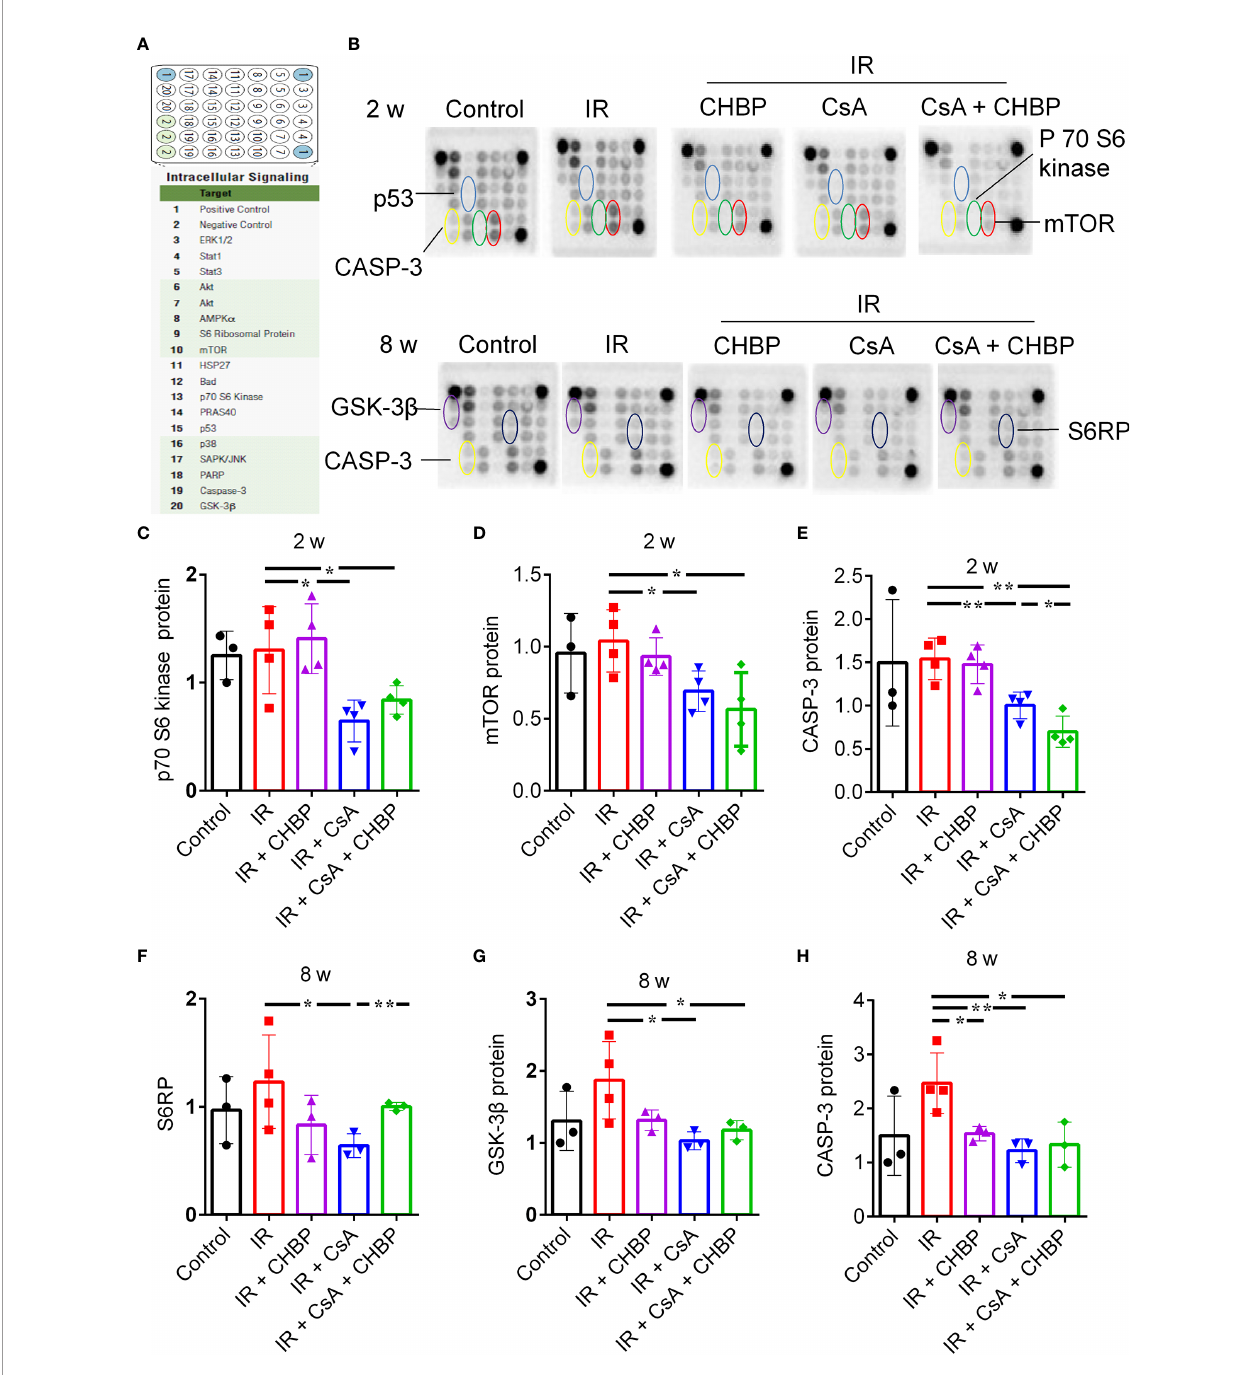
FIGURE 6 | Simultaneous detection of 18 proteins by slide-based antibody array. (A, B) The expression of 18 proteins in the kidneys revealed by slide-based antibody array. (C – E) CsA decreased p70 S6 kinase, mTOR and caspase-3 at 2 weeks. (F – H) S6RP was decreased by CsA in IR kidneys, but reversed by CHBP. CsA decreased GSK-3 b and caspase-3 at 8 weeks in IR kidneys with/without CHBP treatment. (E – H) Caspase-3 was decreased by CHBP in CsA treated IR kidneys at 2 weeks and in IR kidneys at 8 weeks. Data were expressed as the mean ± SD (n ≥ 3). The volume density was corrected by against the control. * P ≤ 0.05; ** P ≤